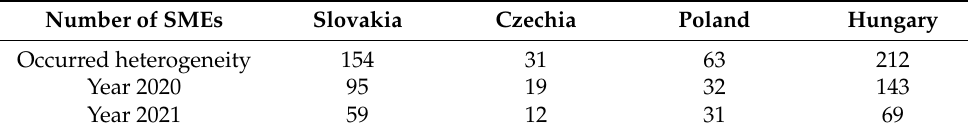
Figure 10. Heterogeneity in Czechia.